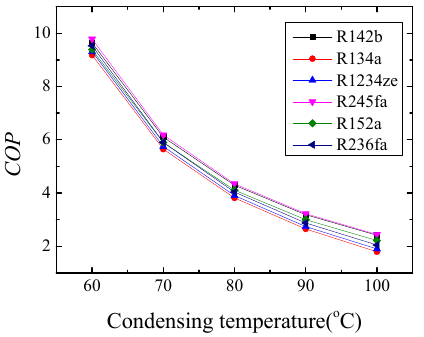
Figure 3. Comparison of COP among different refrigerants.